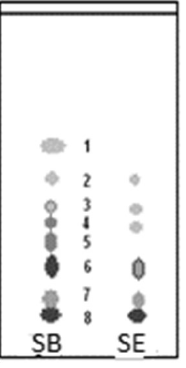
Fig. 6. Thin layer chromatography of chloromethylene substance extract (SB) and